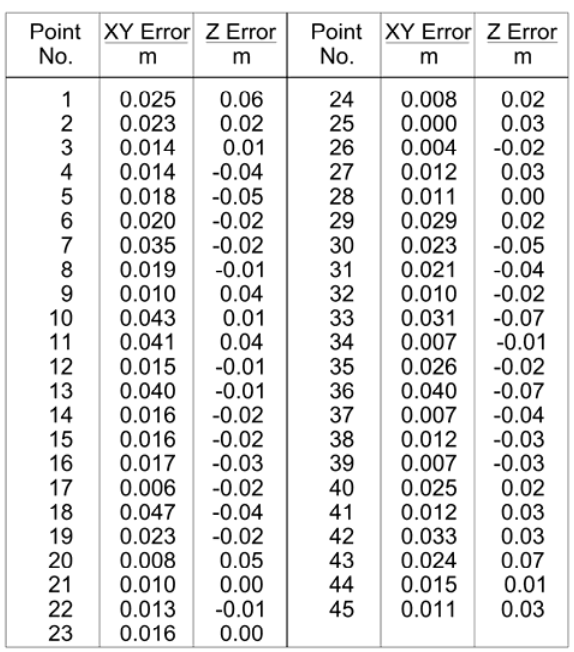
Figure 7: The dataset of measured errors between the Orthomosaic/DEM Network RTK GPS for the target centers.